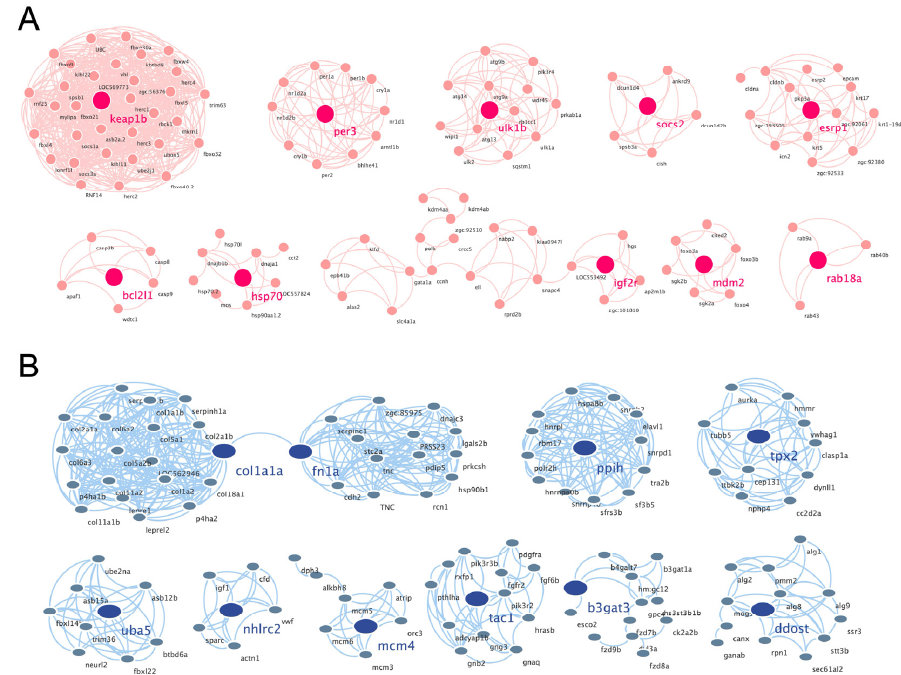
Figure 6. PPI networks of the cluster proteins relating to muscle atrophy caused by excessive exercise. The STRING online database and Cytoscape bioinformatics platform were used to analyze the upregulated ( A ) and downregulated DEGs ( B ) ( p < 0.05, fold change > 2). Table 1. Hub genes of clusters of protein–protein interaction networks. Hub Gene